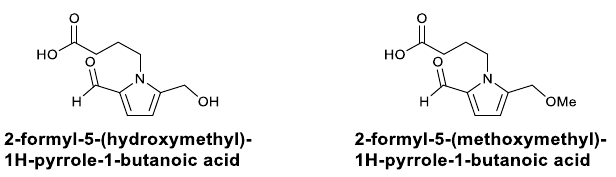
Figure 13. Structures of gonytolide A and its derivatives.